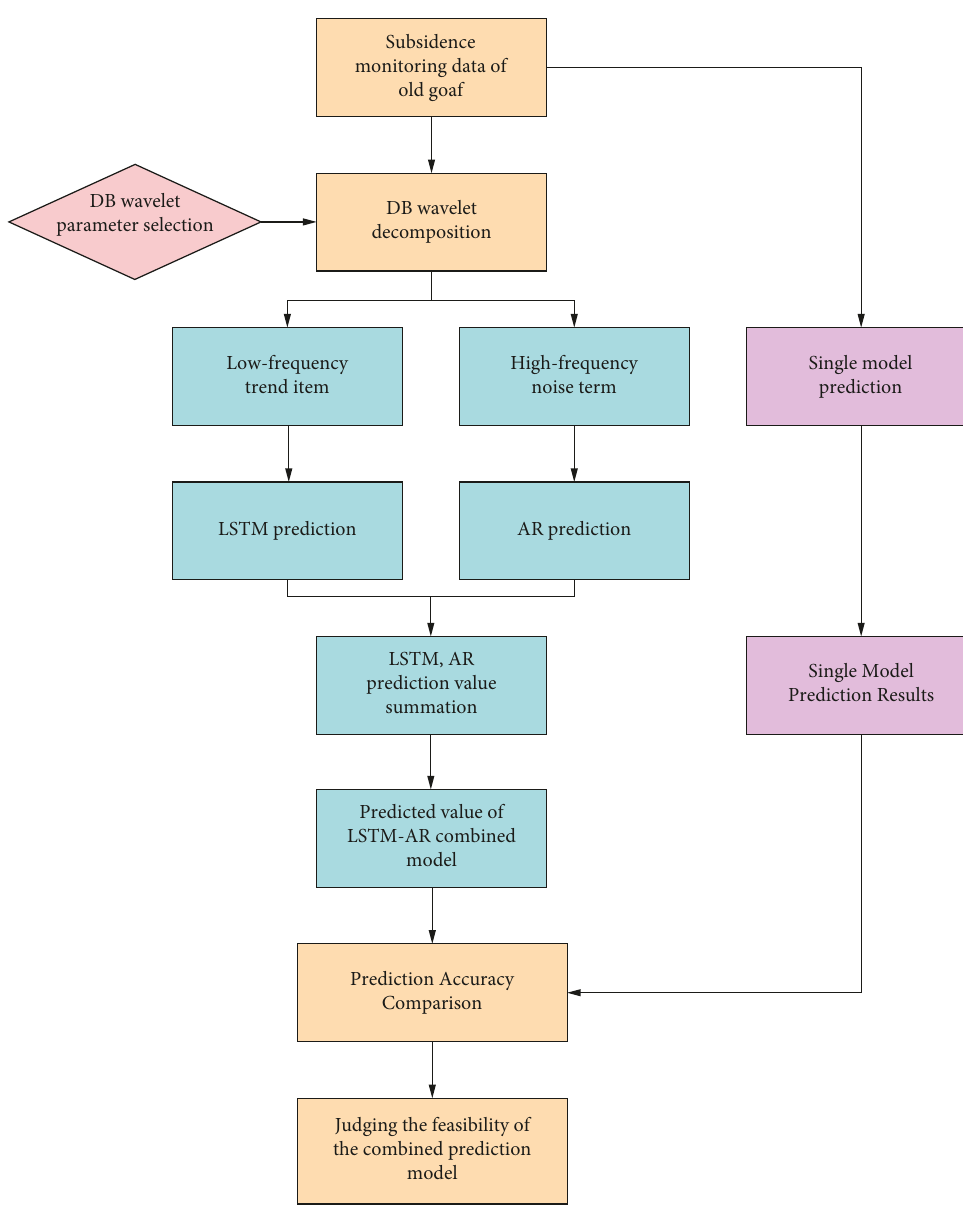
Figure 3: The prediction flow chart.